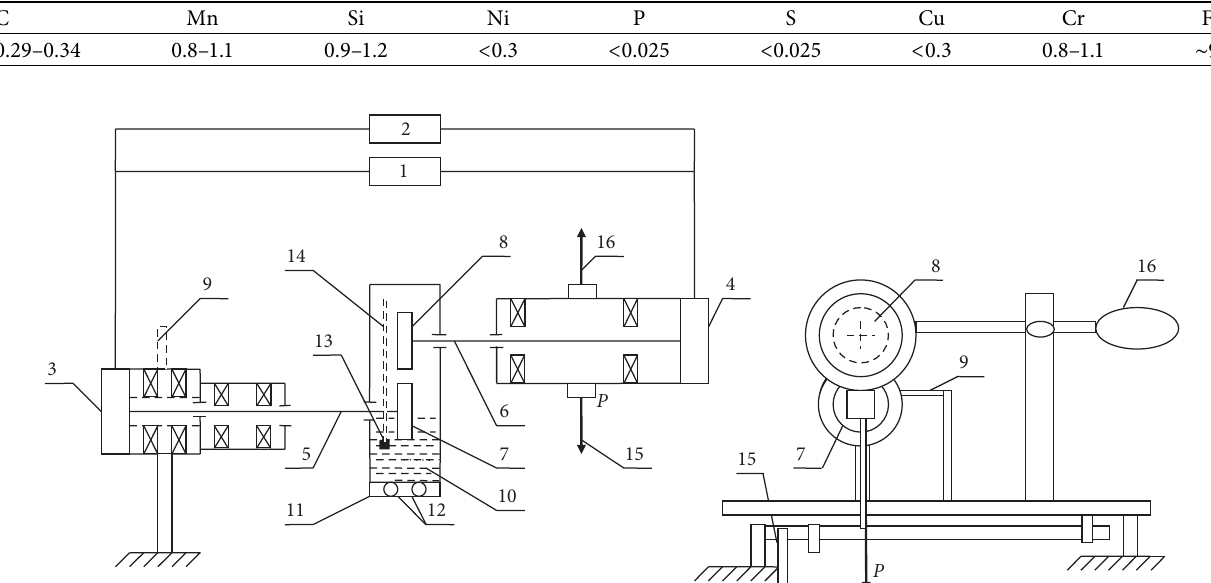
Table 2: Chemical composition of steel 30ChGSA in percentage according to GOST 4543-71.